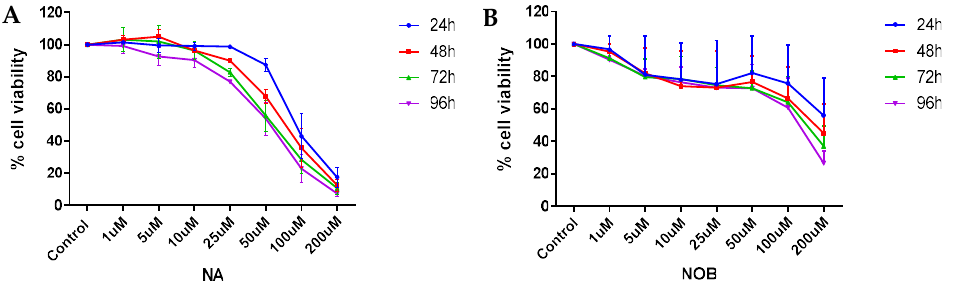
Figure 1. MTT assay was performed on hNPCs following NA and NOB exposure for 24, 48, 72, and 96 h. ( A ) is graphical representation of cell viability with different concentrations of sodium arsenate (NA) and ( B ) showing the cell viability at different concentration of nobiletin (NOB). The values are the mean ± SE of experiment replicates. The data are represented as the mean of the percent of the unexposed control ± SE, n = 2 (biological